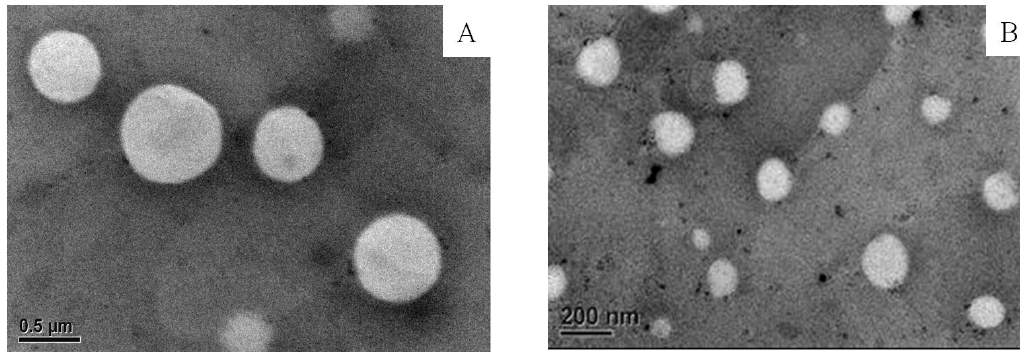
Figure 3. The TEM images of empty liposome (E 60 C 30 T 10 ) filtered through the membrane of 400 ( A ) and 200 nm ( B ). The liposomes were stained with 1 wt % of PTA on carbon-coated cupper grid.